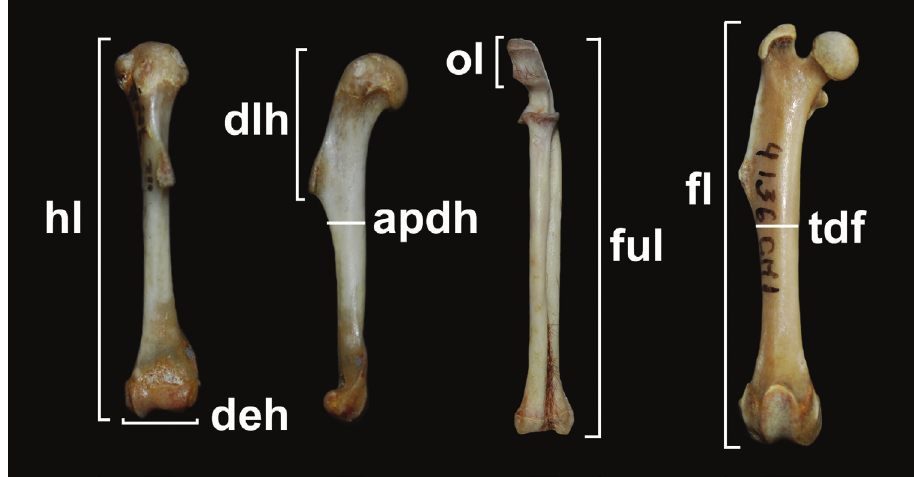
Figure 1. Measurements of the long bones. apdh, anteroposterior diameter of the humerus; deh, di- ameter of the epicondyles; dlh, deltoid length of the humerus; fl, functional femur length; hl, functional humerus length; ful, functional ulna length; ol, length of the olecranon process; tdf, transverse diameter of the